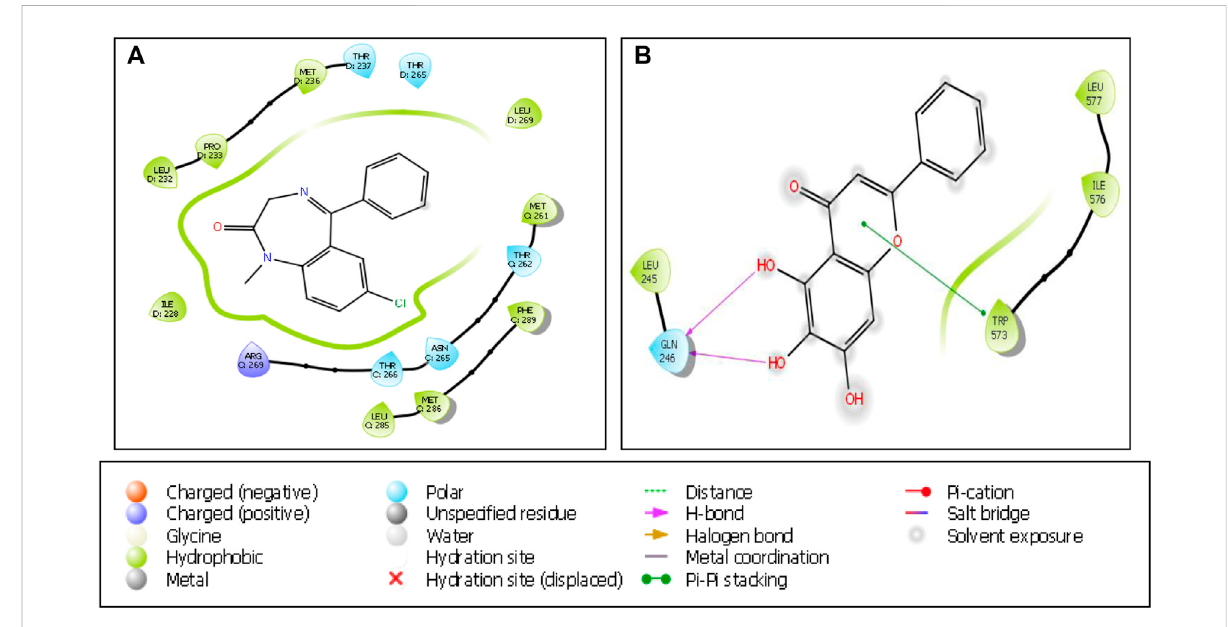
FIGURE 9 Binding interactions of (A) baicalein with GABA (A) receptor (PDB ID: 6X3X) and (B) baicalein with serotonin transporter (PDB ID: